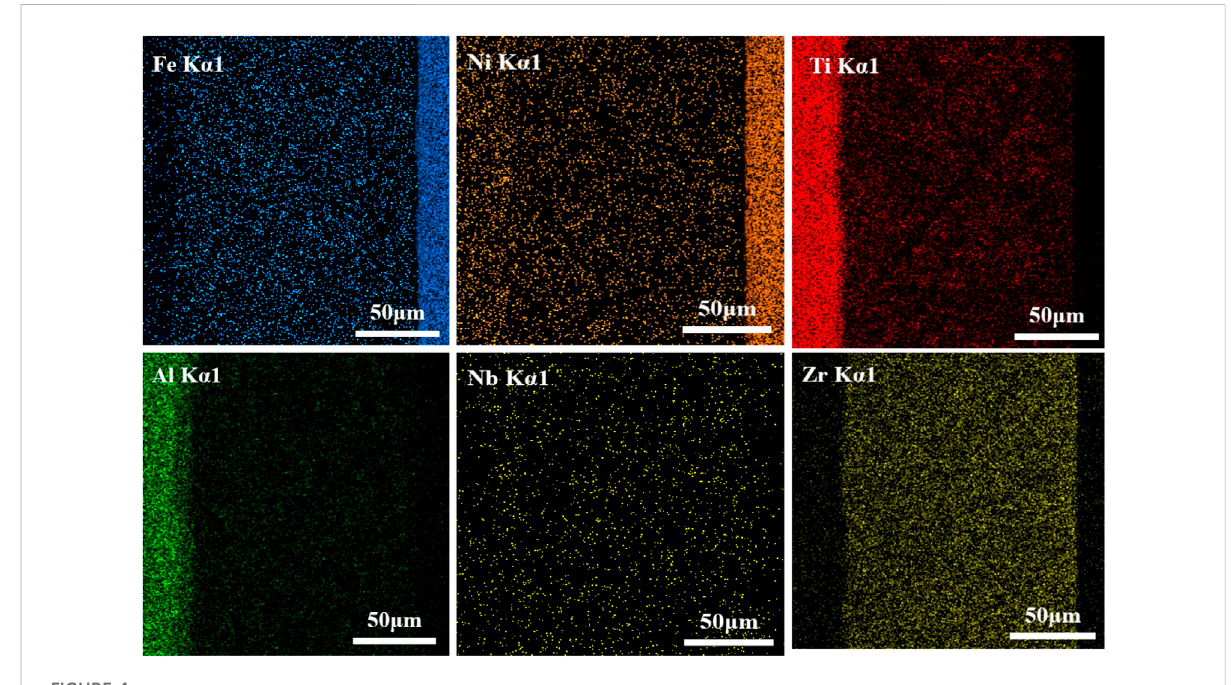
FIGURE 4 EDS map of the joint after brazing at 1090 °